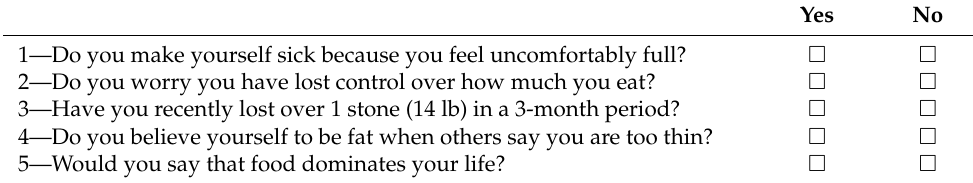
Table 2. Sick-Control-One Stone-Fat-Food (SCOFF)